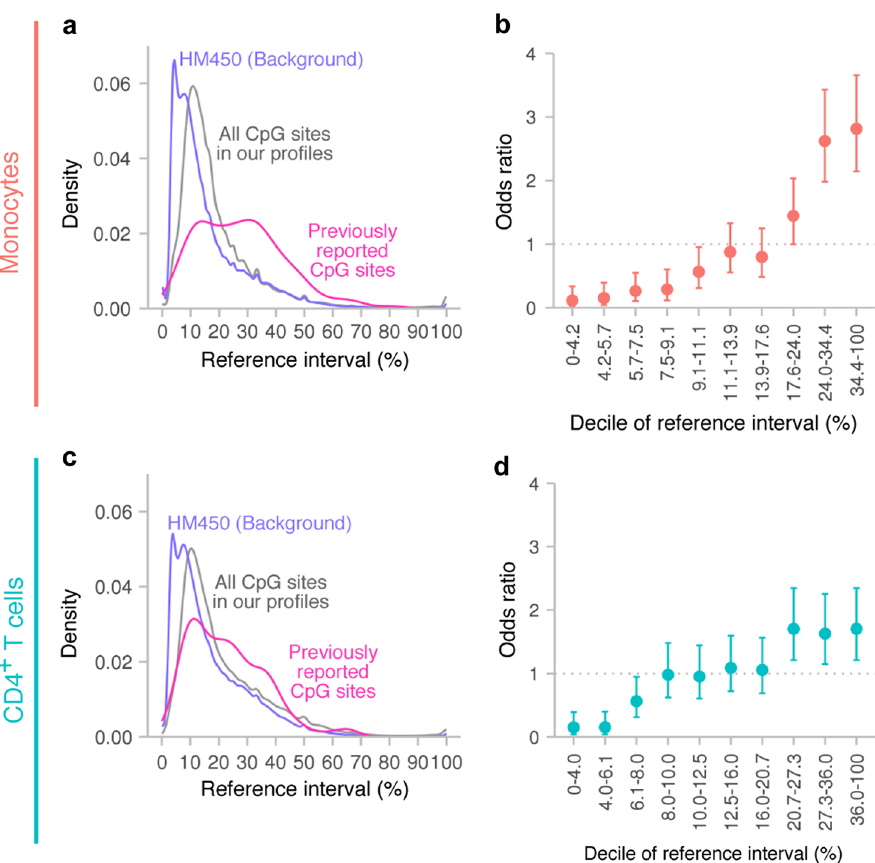
Fig. 3 Validity of the CDMV hypothesis. a Reference interval distributions in monocytes. The reference interval distribution for the ~24 million CpG sites included in our comprehensive pro fi les is indicated in grey . The reference interval distribution for CpG sites probed by HumanMethylation450 (HM450) is shown in purple . The reference interval distribution for CpG sites previously reported by blood-based EWASs is represented in magenta . b OR in monocytes. CpG sites probed by HM450 are categorized into ten groups according to reference interval deciles. The OR was estimated by comparing biomarker likelihood for each group of CpG sites with that for all CpG sites probed by HM450 (average biomarker likelihood). Labels in the x -axis represent ranges of DNAm levels as a percentage for each decile. The 95% CIs are shown as solid lines . c Reference interval distributions in CD4 + T cells. d OR in CD4 + T